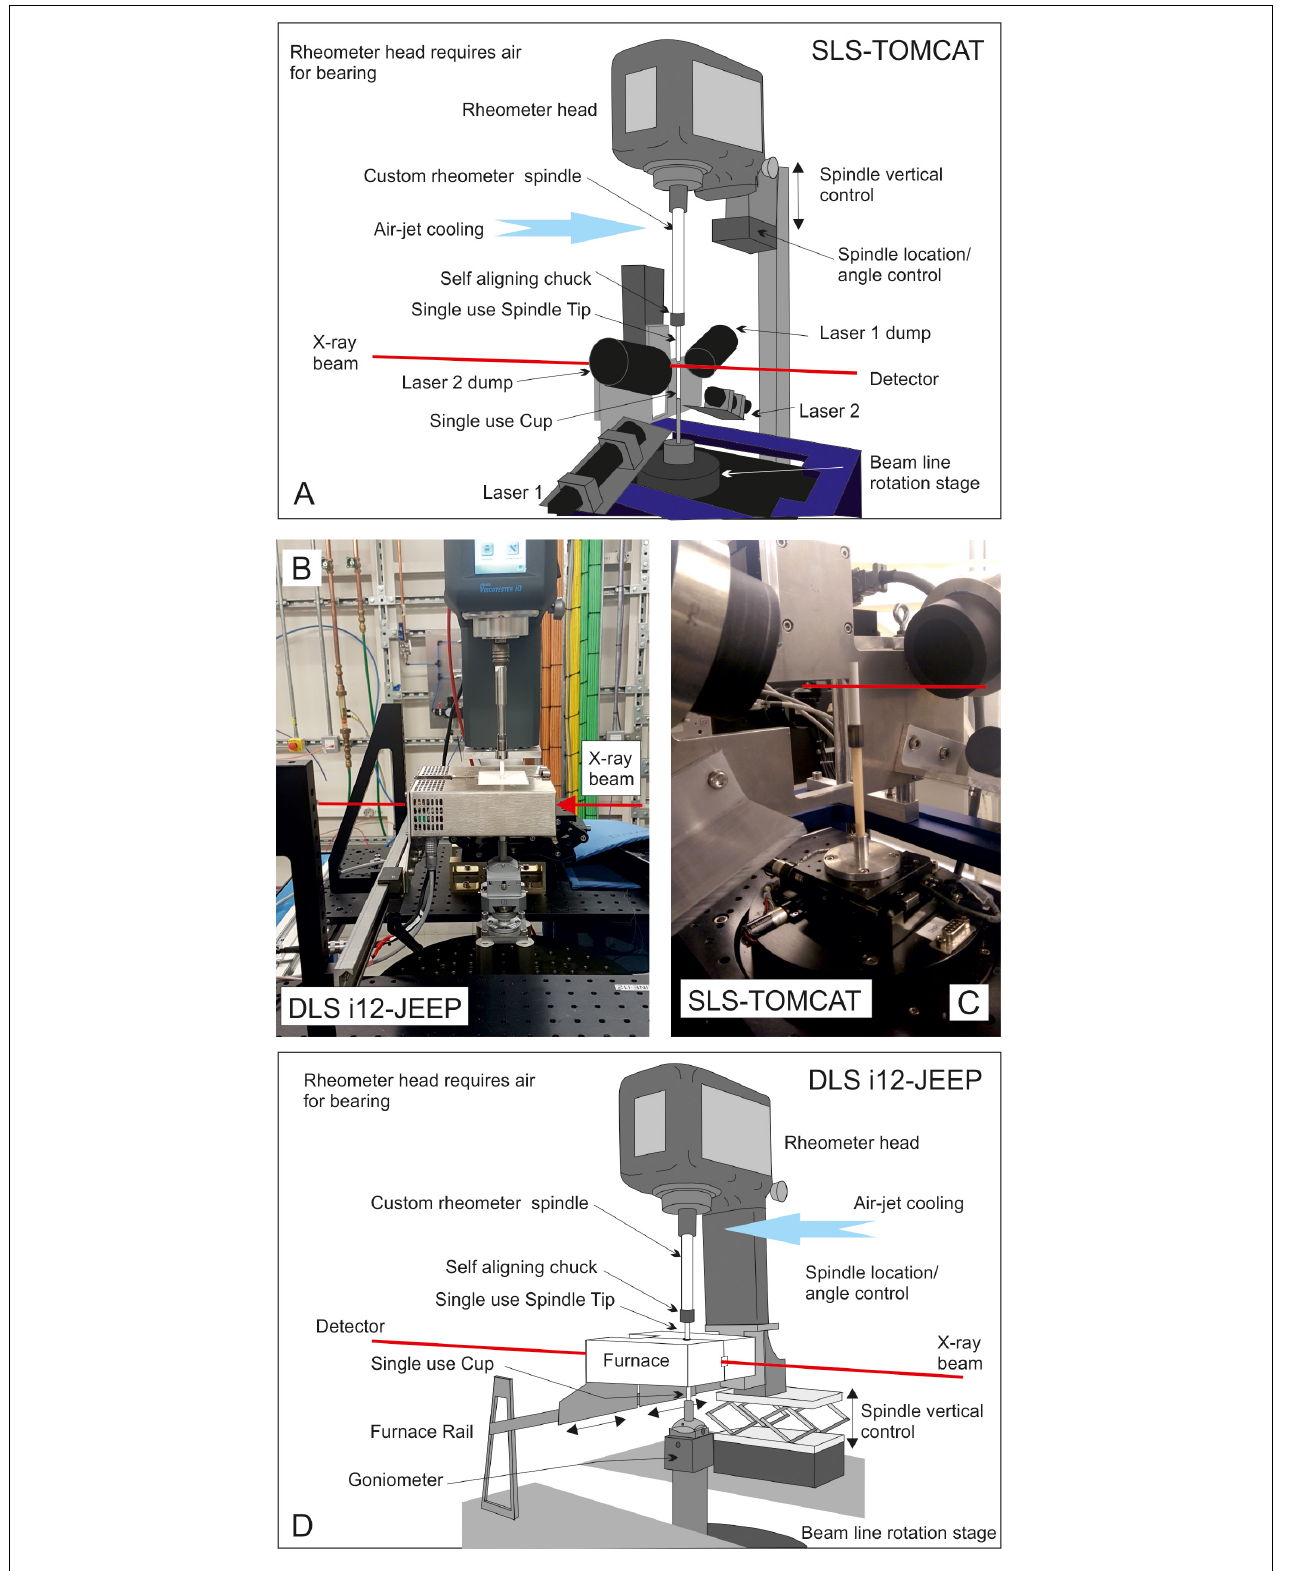
FIGURE 1 | Schematics of the XRheo and its installation at the TOMCAT (Swiss Light Source) (A,C) and at i12 (Diamond Light Source) (D,B) beamlines. This mounting system can be easily adapted to other synchrotron or laboratory systems, and the system can be used ex situ for laboratory bench testing.